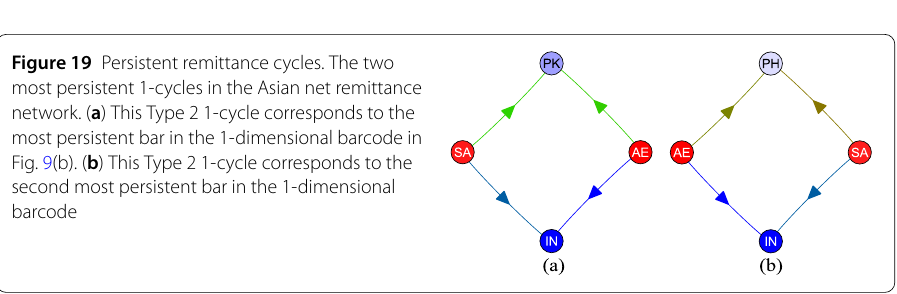
Figure 18 Cyclic flow of remittances in Asia. 1-cycle generators for the 2015 Asian net remittance network